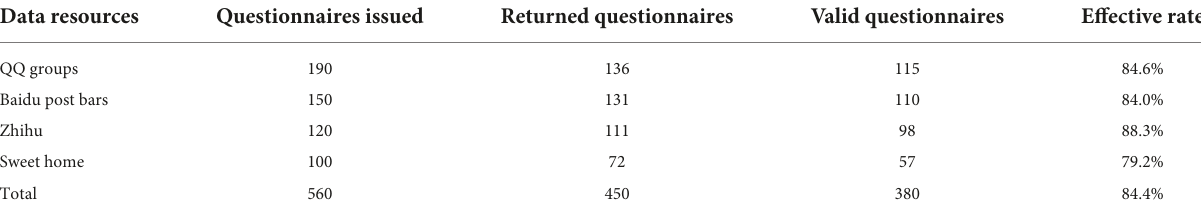
TABLE 1 Sample statistics for the questionnaire. Data resources